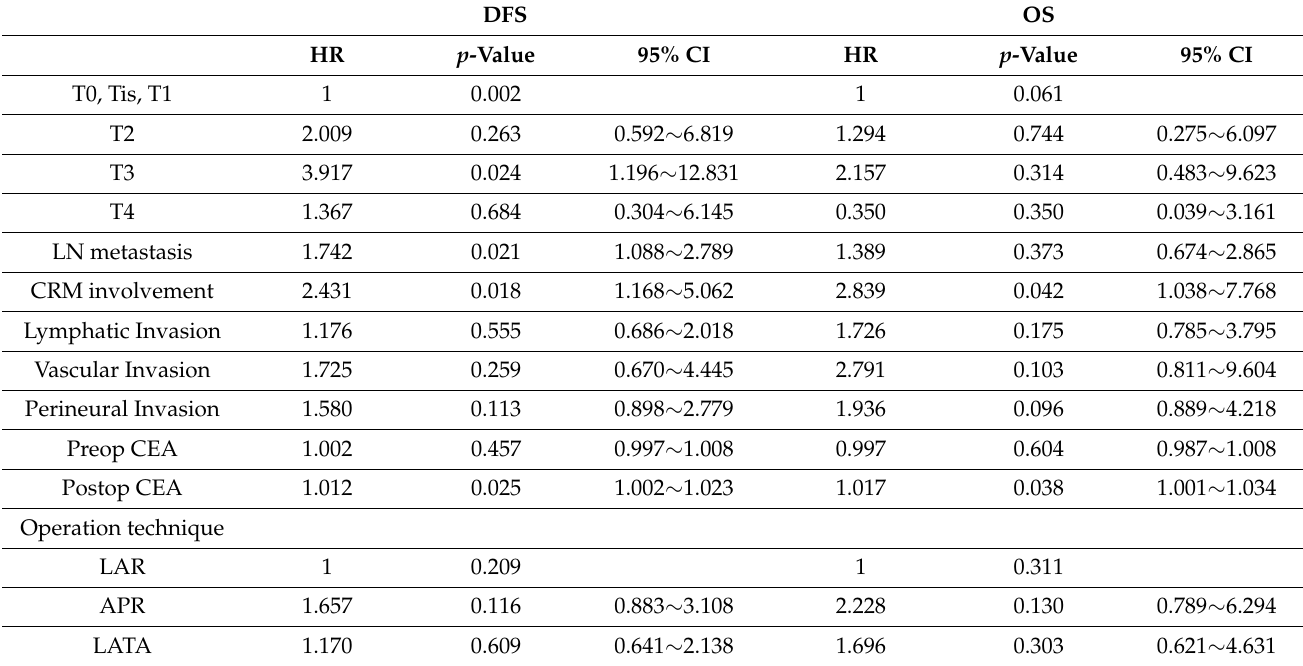
Table 6. The results of oncologic outcomes according to significant factors through the multivariate Cox regression